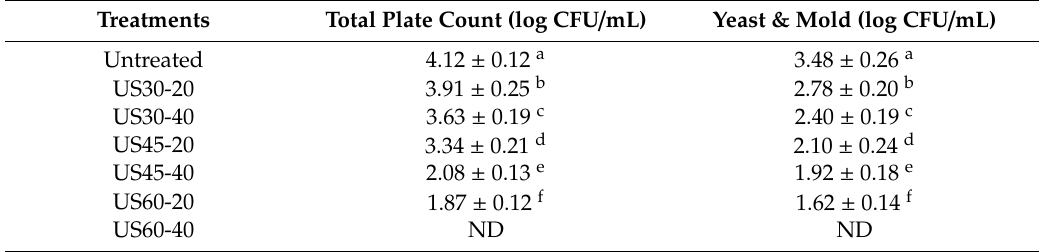
Table 2. Impact of thermal–ultrasound (TU) treatments on the survival of